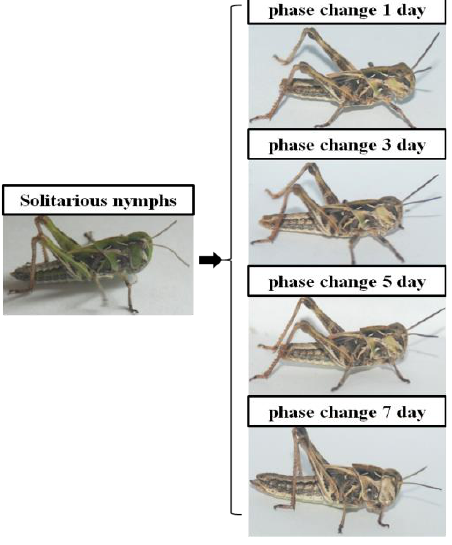
Figure 1. Phenotypic change in O. asiaticus on days 1, 3, 5, and 7 (from top to bottom) after high- density treatment.